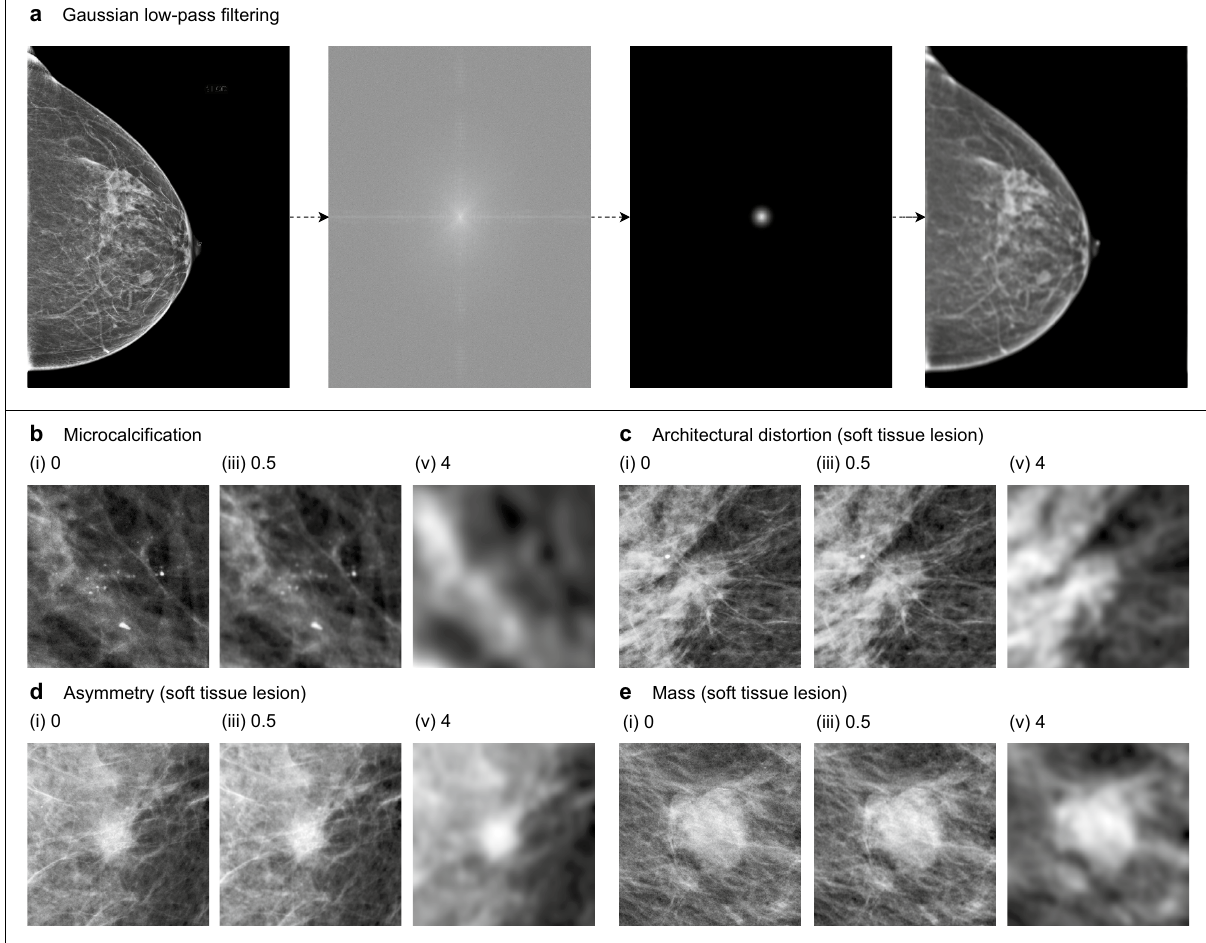
Figure 1. Identification of subgroups and an input perturbation. In our breast cancer screening case study, we separately analyzed two subgroups: microcalcifications and soft tissue lesions, using Gaussian low-pass filtering as the input perturbation. (a) Gaussian low-pass filtering is composed of three operations. The unperturbed image is transformed to the frequency domain via the two-dimensional discrete Fourier transform (DFT). A Gaussian filter is applied, attenuating high frequencies. The image is then transformed back to the spatial domain with the inverse DFT. (b–e) Gaussian low-pass filtering applied to various types of malignant breast lesions. Subfigures (i–iii) show the effects of low-pass filtering of increasing severity. (b) Microcalcifications are tiny calcium deposits in breast tissue that appear as white specks. Radiologists must often zoom in significantly in order to see these features clearly. Since these microcalcifications have a strong high frequency component, their visibility is severely degraded by low-pass filtering. (c) Architectural distortions indicate a tethering or indentation in the breast parenchyma. One of their identifying features are radiating thin straight lines, which become difficult to see after filtering. (d) Asymmetries are unilateral fibroglandular densities that do not meet the criteria for a mass. Low-pass filtering blurs their borders, making them blend into the background. (e) Masses are areas of dense breast tissue. Like asymmetries, masses generally become less visible after low- pass filtering, since their borders become less distinct. In our subgroup analysis, we aggregated architectural distortions, asymmetries, and masses into a single subgroup called “soft tissue lesions.” This grouping was designed to distinguish between localized and nonlocalized lesions. Soft tissue lesions on the whole are far less localized than microcalcifications, and they require radiologists to consider larger regions of the image during the process of diagnosis. Figure created with drawio v13.9.0 https:// github. com/ jgraph/